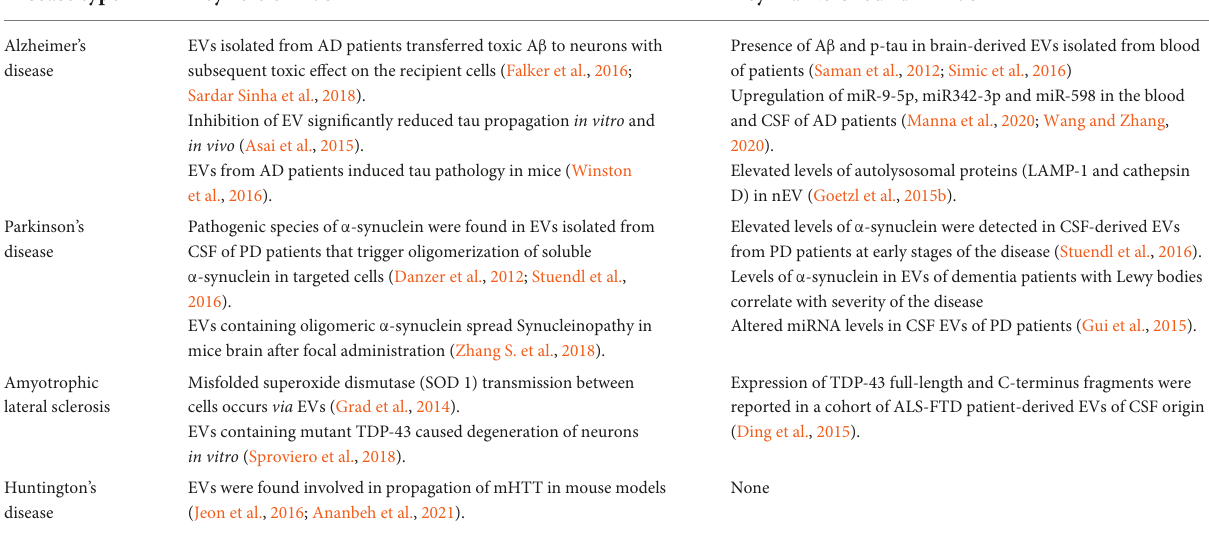
TABLE 2 Current knowledge about role of EVs in Pathophysiology of